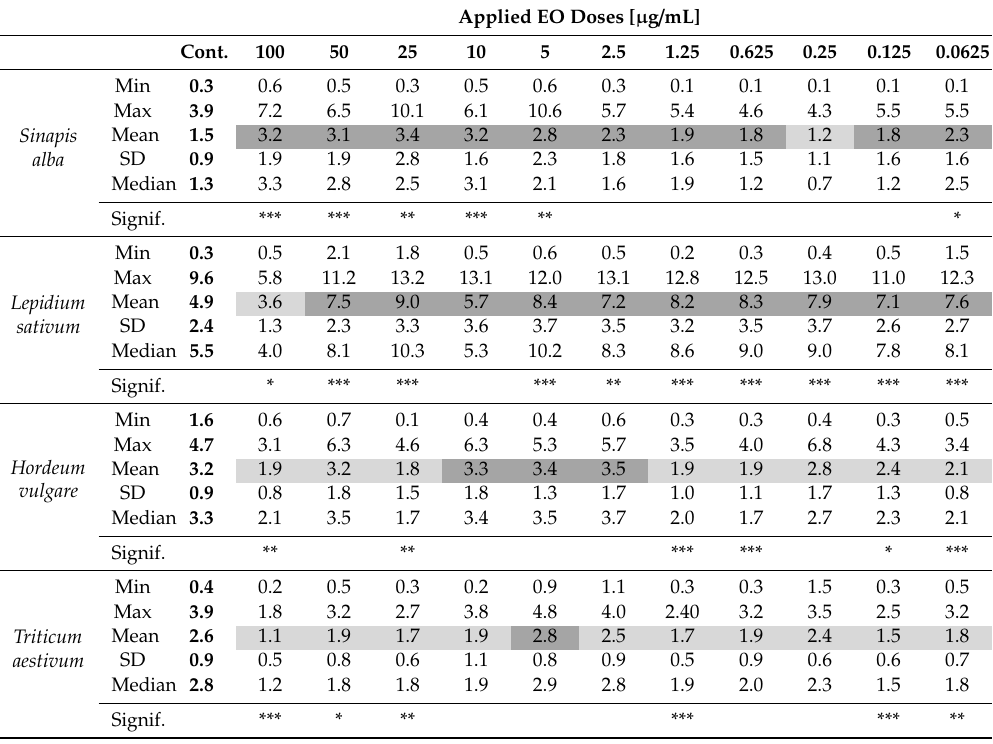
Table 3. Average roots length in cm of particular model organisms in comparison to control after exposition to different doses of Origanum vulgare EO.